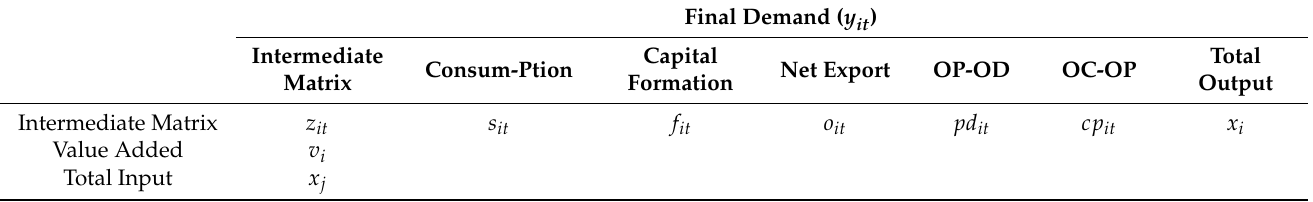
Table 1. Simplified version of I-O table.